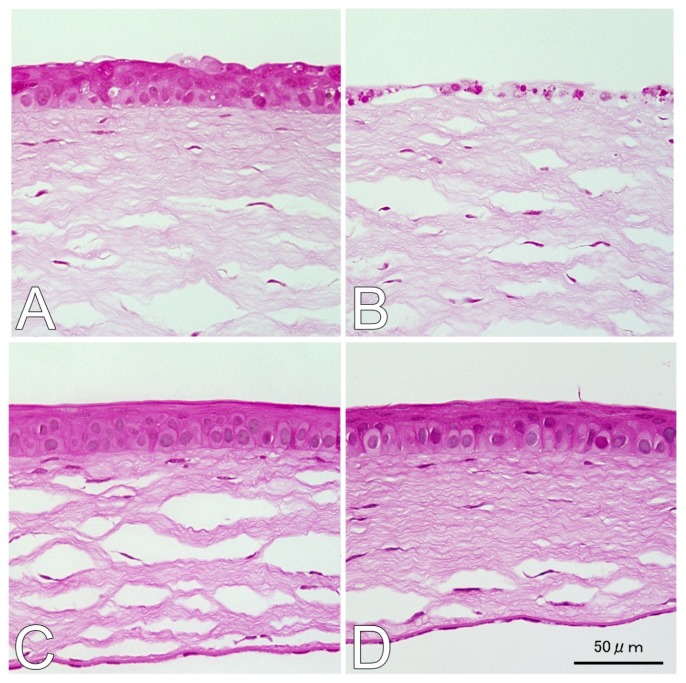
Morphological properties of ultraviolet (UV) B-irradiated corneas (A) Irradiated eyes of mice treated with geranylgeranylacetone (GGA); (B) Irradiated eyes of mice without GGA administration; (C) Unirradiated eyes of mice administered with GGA; (D) Naive corneas; (E) Mean corneal epithelium thickness. Data are shown as mean ± SEM (n = 10), **p < 0.01; n.s. p > 0.05 (Mann-Whitney U-Test).